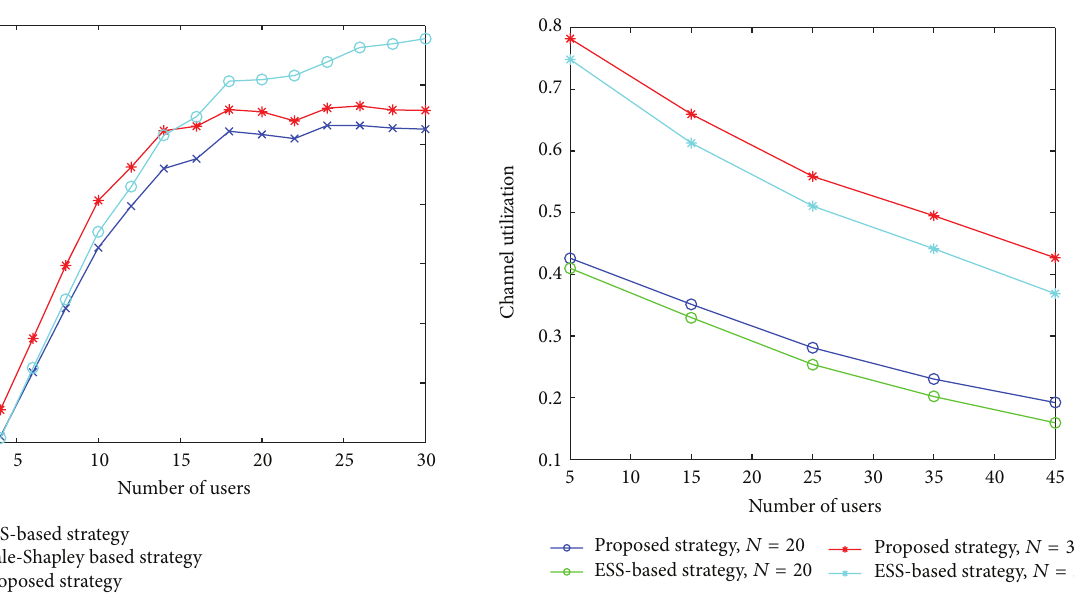
Figure 3: System throughput under different channel selection strategies.